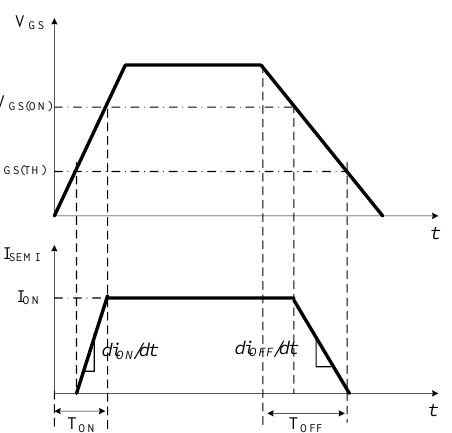
Figure 4. Concept of ON and OFF chacteristics of semiconductor switch (IGBT).